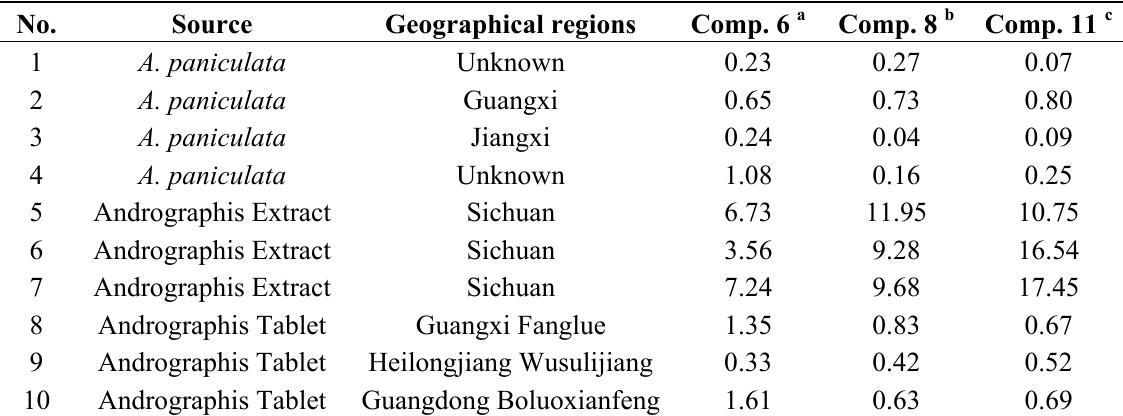
Table 3. Description of the test